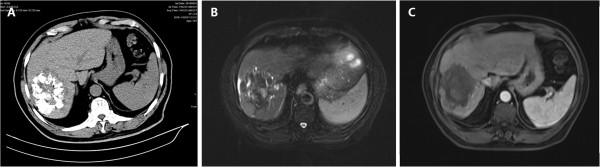
Incomplete ablation of HCC. A: CT image before RFA; B and C: MRI image after RFA.